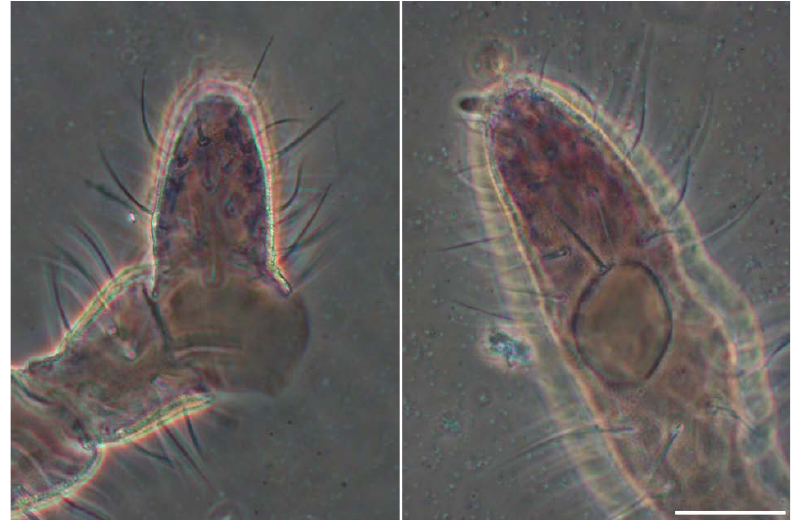
Figure 2. Ceratophysella meridionalis : antennal segments I to IV, dorsal view at left ( A ); ventral view at right ( B ) (av, apical vesicle; ms, microsensillum; or, subapical organite; es, eversible sac) (scale bar, 0.05 mm).